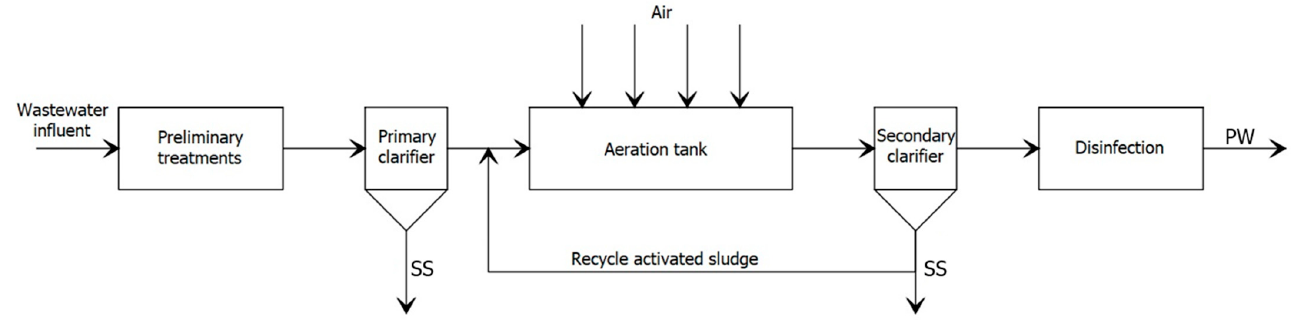
Figure 2. Schematic diagram of a typical activated sludge WWTP. Figure 3 schematically shows a Traditional Seawater Reverse Osmosis (TSWRO) process.